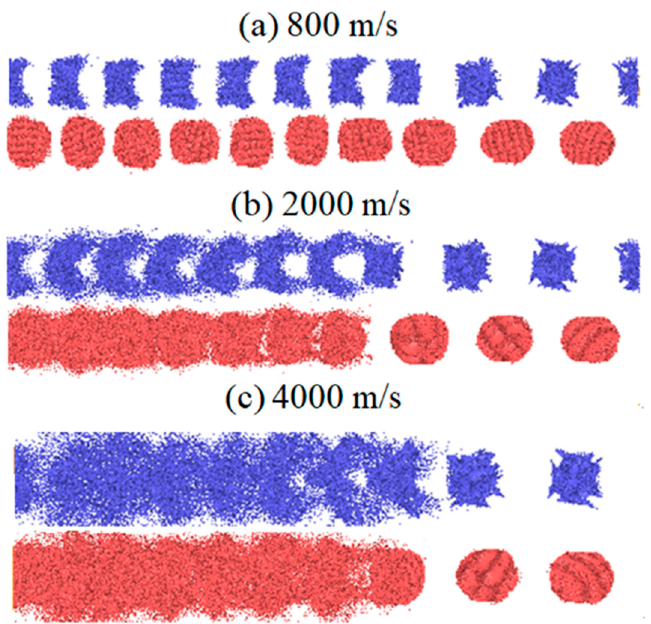
Figure 10. Deformation states of two particles under different impact speeds (Fe particles are colored in red and Al particles are colored in blue).